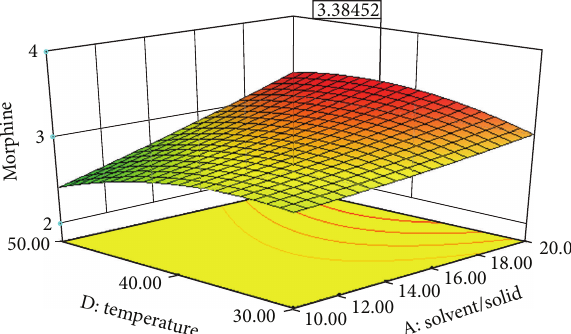
Figure 2: Response surface plot for the EY of poppy straw as a function of solvent/solid ratio ( 𝑋1 ) to solvent pH ( 𝑋2 ).